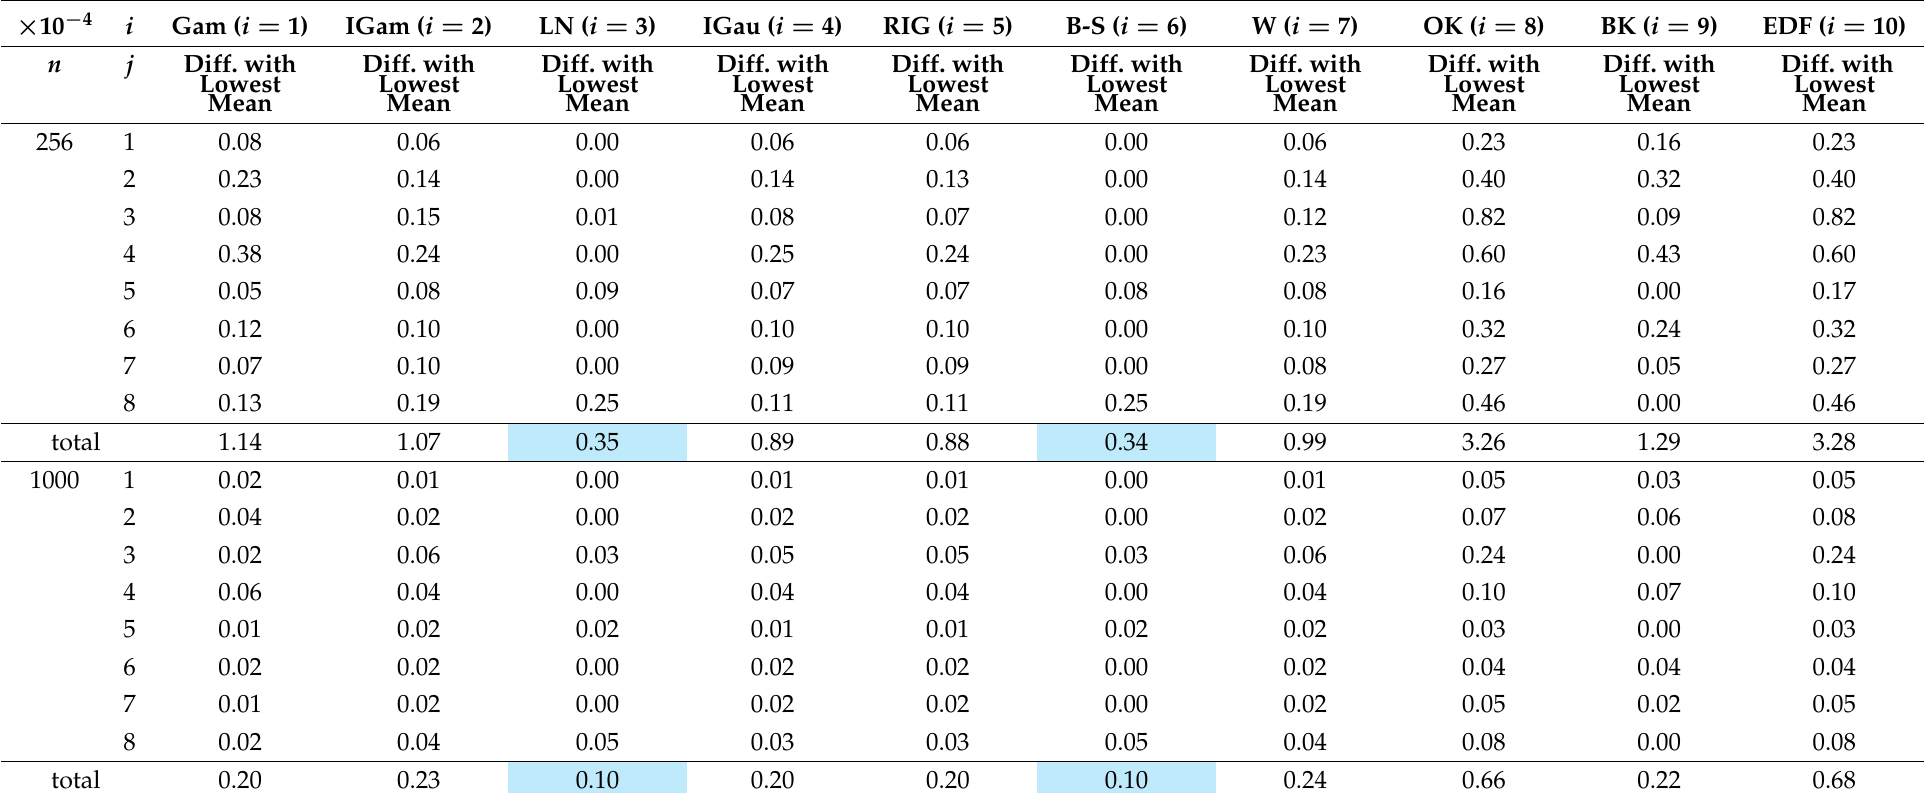
Table 2. For each of the eight target distributions ( i = 1,2, . . . ,8) and each of the two sample sizes ( n = 256,1000), a cell represents the mean of the ISE lowest ISE mean for that line (i.e., minus the ISE mean of the best estimator for that specific target distribution and sample size). For each estimator ( j = 1,2, . . . ,10) and each sample size, the total of those differences to the best ISE means is calculated on the line called “total”. For each sample size, the lowest totals are highlighted in